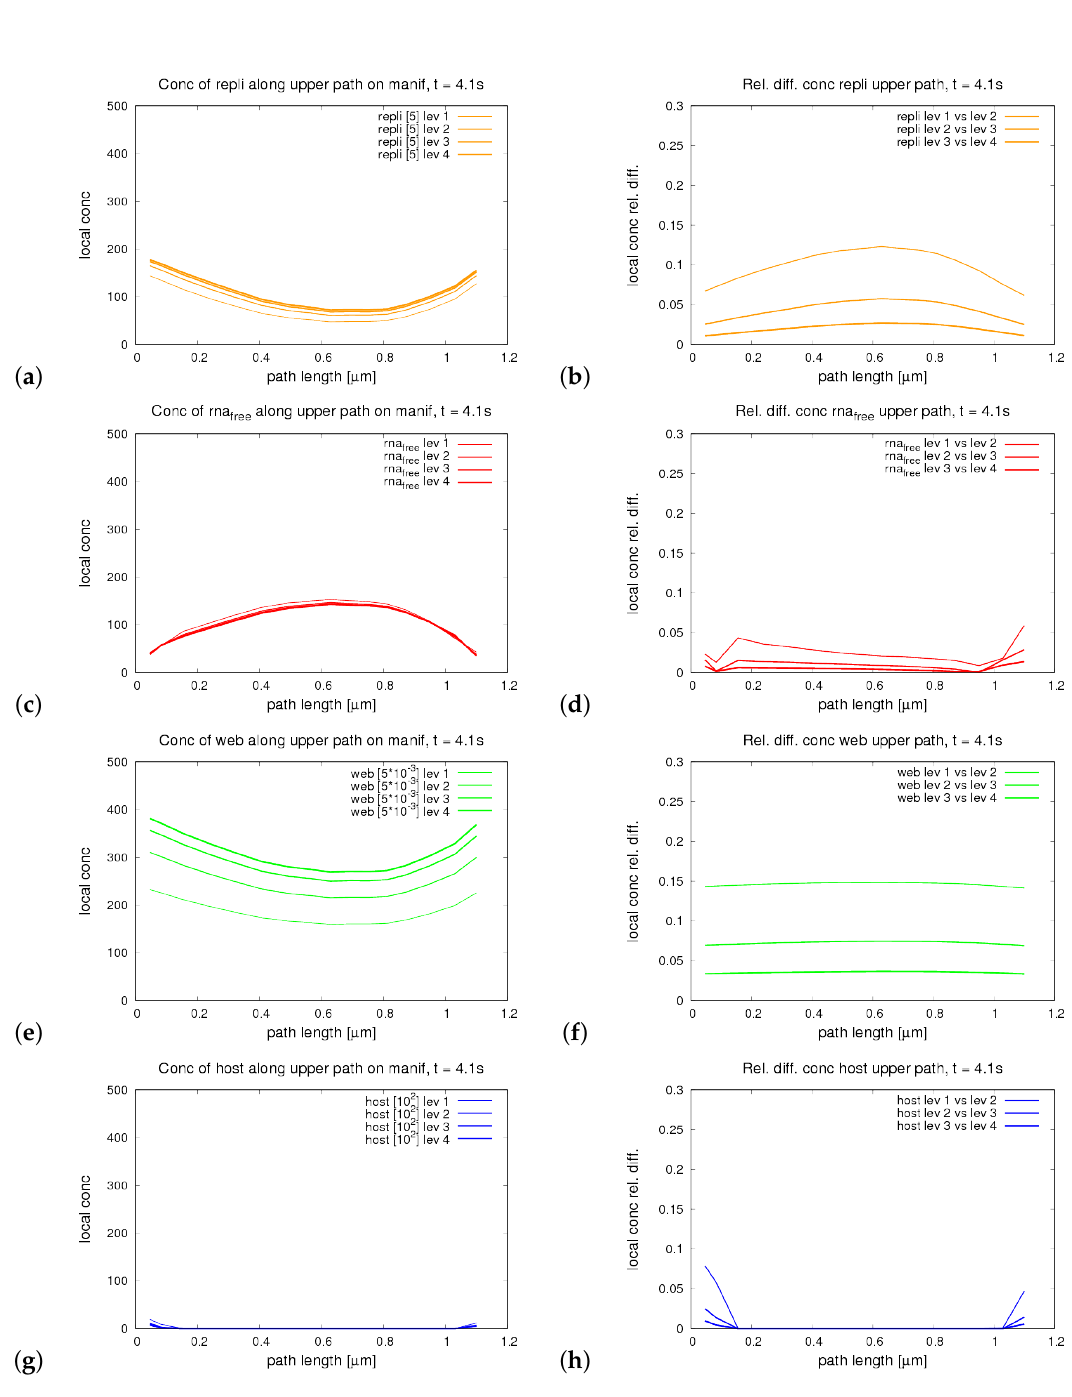
Figure A6. Variation of spatial refinement level for the 1D profiles of the concentrations around a web region. Upper sub path. ( a ) Replication complex absolute values, ( b ) replication complex relative differences, ( c ) Free RNA absolute values, ( d ) free RNA relative differences, ( e ) web protein absolute values, ( f ) web protein relative differences, ( g ) host factor absolute values, ( h ) host factor relative differences. (Note that, where the host factor is effectively depleted, relative differences are replaced by absolute